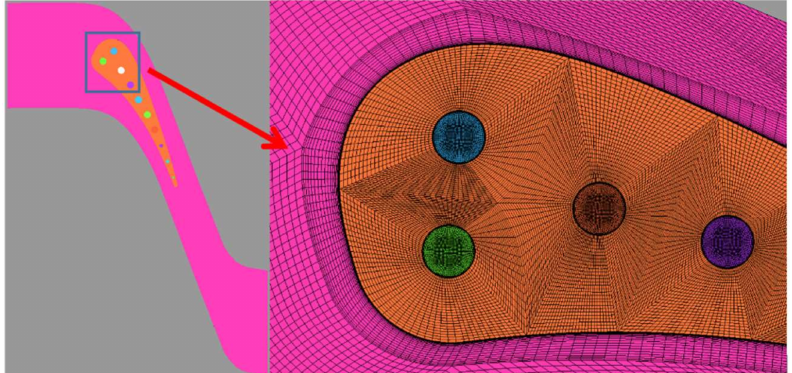
Figure 4. Computational mesh shown at midspan.